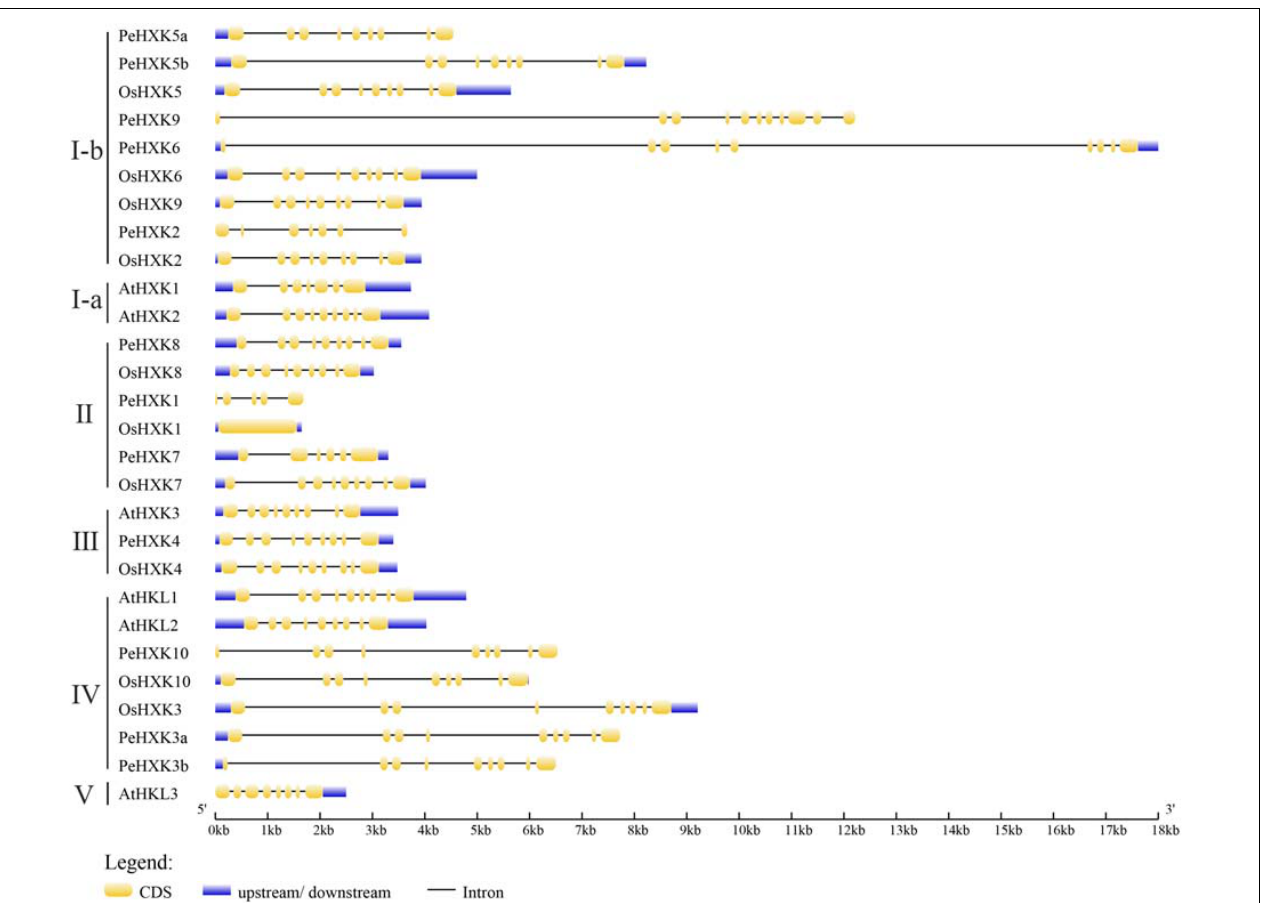
FIGURE 3 | Conserved domain alignment for predicted moso bamboo family proteins. The sequences from moso bamboo, Arabidopsis thaliana , and rice were aligned using MUSCLE. Annotations are based on regions homologous to yeast HXK2 (Kuser et al., 2000). P1, phosphate 1; P2, phosphate 2. The alignment was performed using SeaView4 software (Gouy et al.,